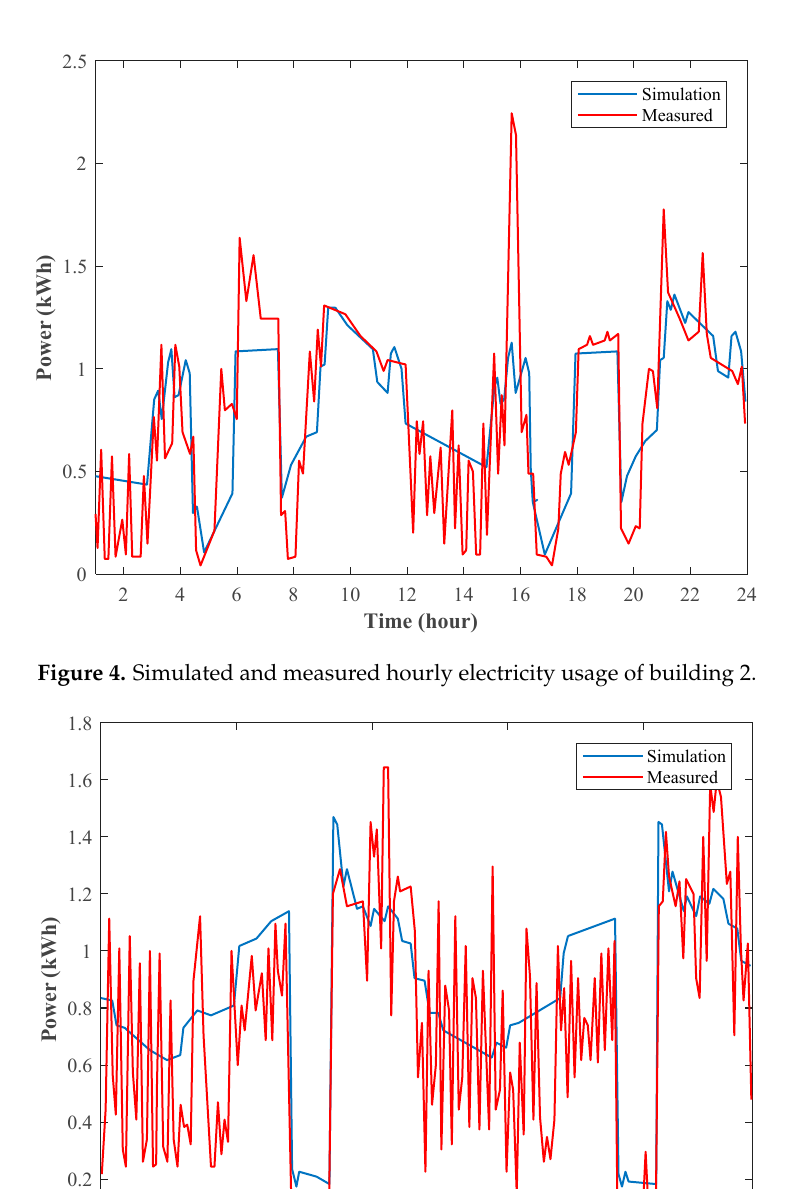
Figure 3. Simulated and measured hourly electricity usage of building 1.